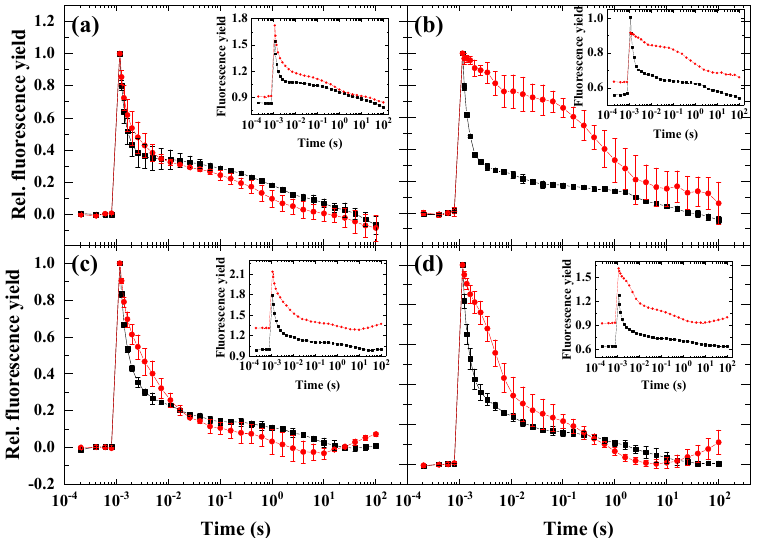
Figure 1. Flash-induced fluorescence relaxation under aerobic (black) and microaerobic (red) condi- tions. ( a ) Haematococcus pluvialis (green cells), ( b ) Dunaliella salina , ( c ) Chlorella sorokiniana , ( d ) Nan- nochloropsis limnetica . Curves were normalized (F 0 to 0 and F m(ST) , which represents maximal flu- orescence after the flash to 1) to achieve the same initial amplitudes. The insets show the original curves, averaged over the three biological replicates, without normalization. Error bars represent the standard deviation of the mean of three biological